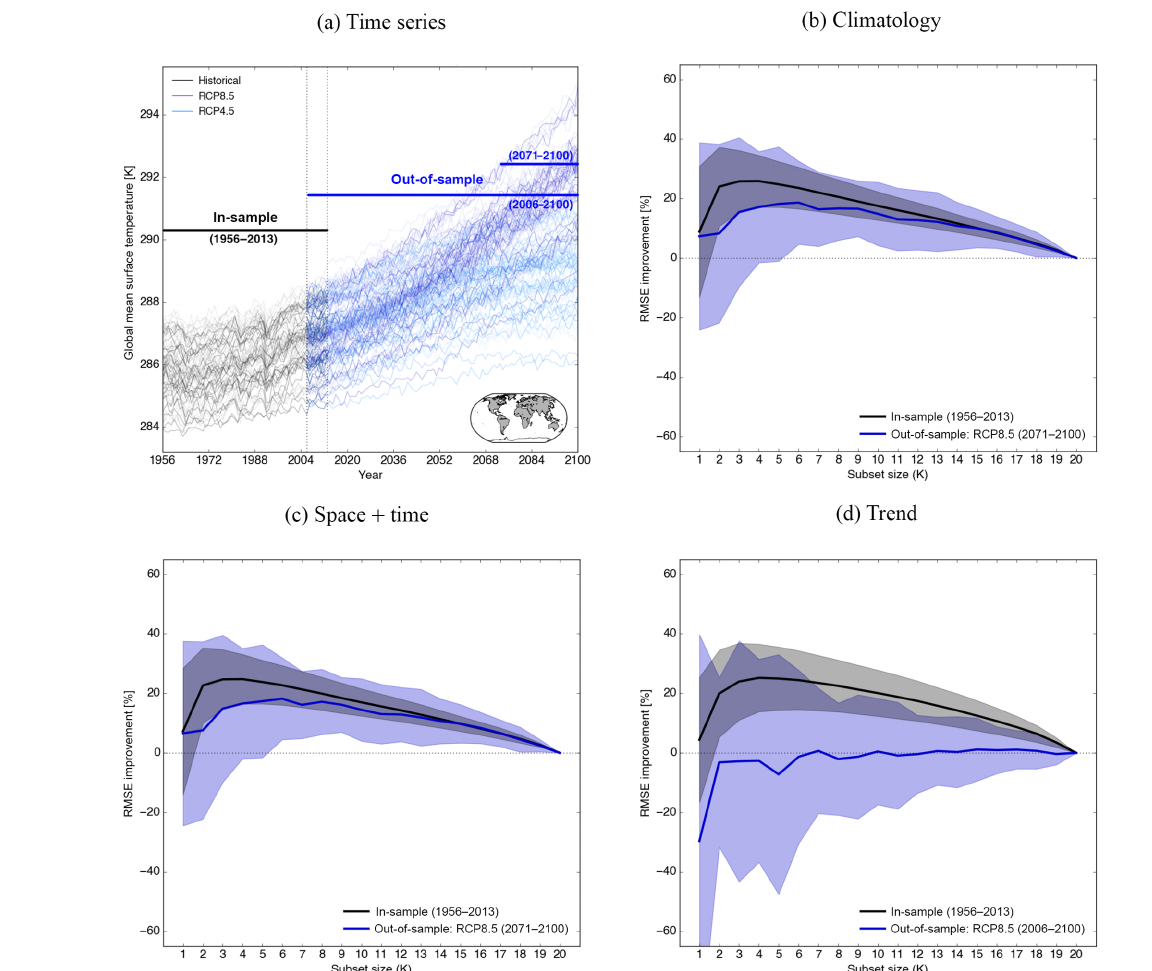
Figure 4. Results of the model-as-truth experiment based on three different metrics (b–d) and 21 model simulations (one simulation per institute). (a) Time series of surface air temperature averaged over the areas where CRUTS3.23 has data availability (see map in lower right corner). The time series of the 21 model simulations which are used for the experiment are plotted slightly thicker; 1956–2013 was used as in-sample period, in which the optimal subset is derived, and 2006–2100 was used as out-of-sample period for the trend metric and 2071– 2100 for the remaining two metrics. (b) The RMSE improvement of the optimal subset relative to the MMM is plotted as a function of the subset size for each model simulation as truth. The subset for each given ensemble size was derived in the in-sample period based on the climatological metric. The curve is the mean improvement across all the 21 model simulations as “truth” and the shading around it represents the spread. Black was used for the historical period and dark blue for RCP8.5; (c) and (d) show the same as (b) but for different